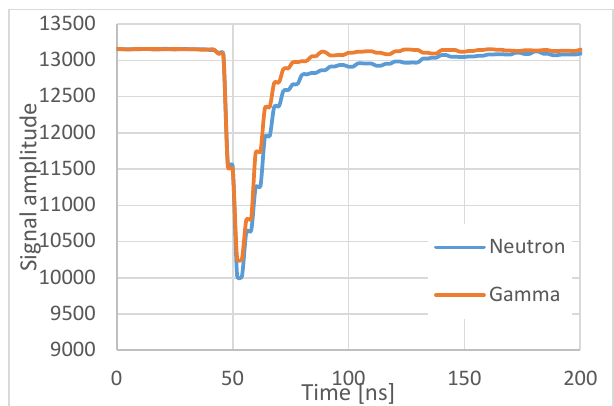
Figure 2 Typical shapes of gamma rays and neutrons